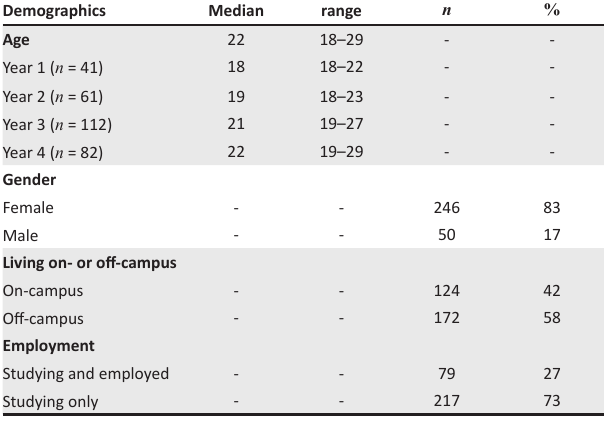
TABLE 1: Characteristics of the participants ( n = 296).